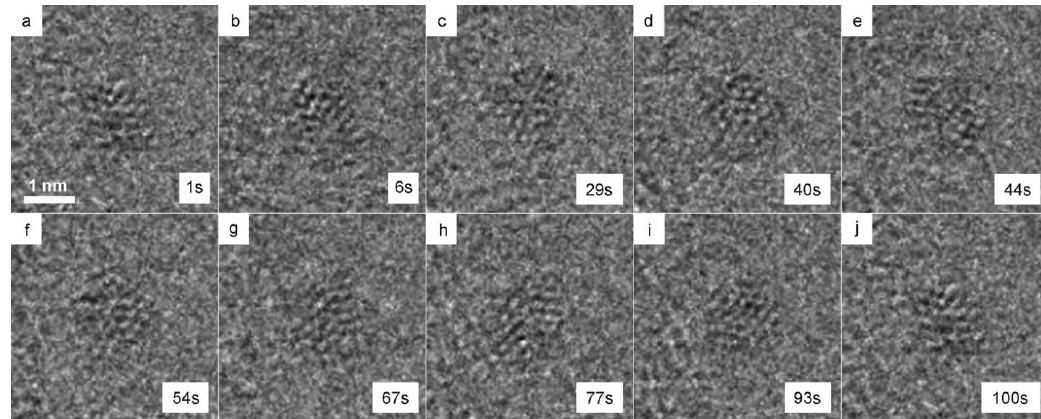
Figure 7. Dynamic changes of a small Au particle supported on activated carbon under electron beam irradiation at various observation times. Electron doses: (a) 1.1×10 6 , (b) 6.6×10 6 , (c) 31.9×10 6 , (d) 44×10 6 , (e) 48.4×10 6 , (f) 59.4×10 6 , (g) 73.7×10 6 , (h) 84.7×10 6 , (i) 102.3×10 6 , (j) 110×10 6 e − nm −2 . Adapted with permission from [119], John Wiley and Sons, 2011.